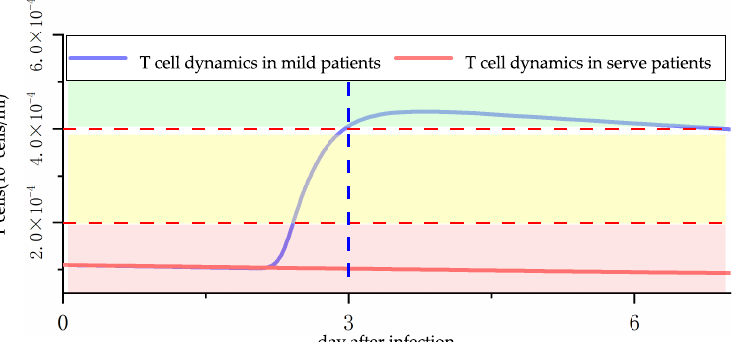
Figure 11. T cell changes in mild and severe disease patients without treatment. The T cell concentra- tion is measured on the third day, and if the value is lower than 2 × 10 5 cells/mL (red part), drug treatment should be administered the same day; if it is higher than 2 × 10 5 cells/mL and lower than 4 × 10 5 cells/mL (yellow part), more clinical information should be used to determine whether drug treatment is needed; if it is higher than 4 × 10 5 cells/mL (green part), general treatment should be